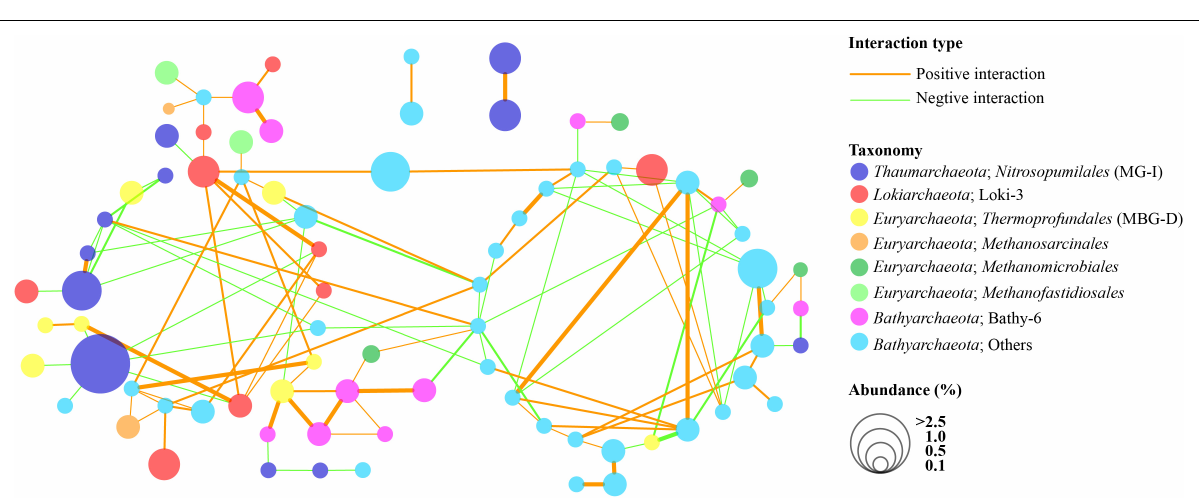
FIGURE 7 | Co-occurrence and co-exclusion networks of archaeal communities in the PRE surface sediments on the OTU level (average abundance fraction > 0.1%). Edge width represents the intensity of interactions. Only interactions with bathyarchaeotal OTUs, and confirmed by at least two out of three analysis methods used (i.e. Pearson, Spearman, and Bray–Curtis) at p < 0.01 are